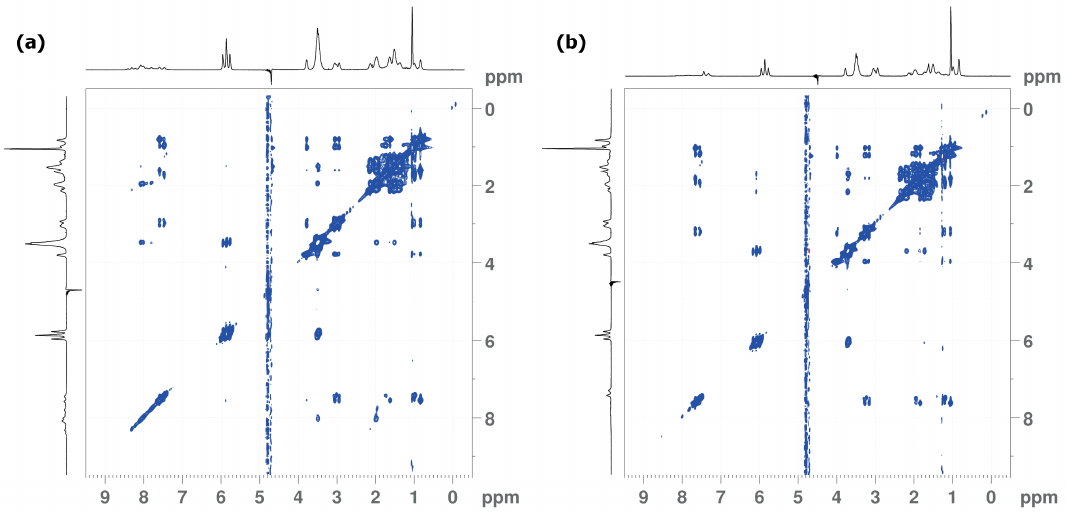
Figure 7. A comparison of NOESY spectra acquired at ( a ) 20 °C and ( b ) 40 °C. The projections of the NOESY spectra were set for the same contour levels; only positive signals were shown to limit the noise after the water signal suppression. External 1 H projection was used.